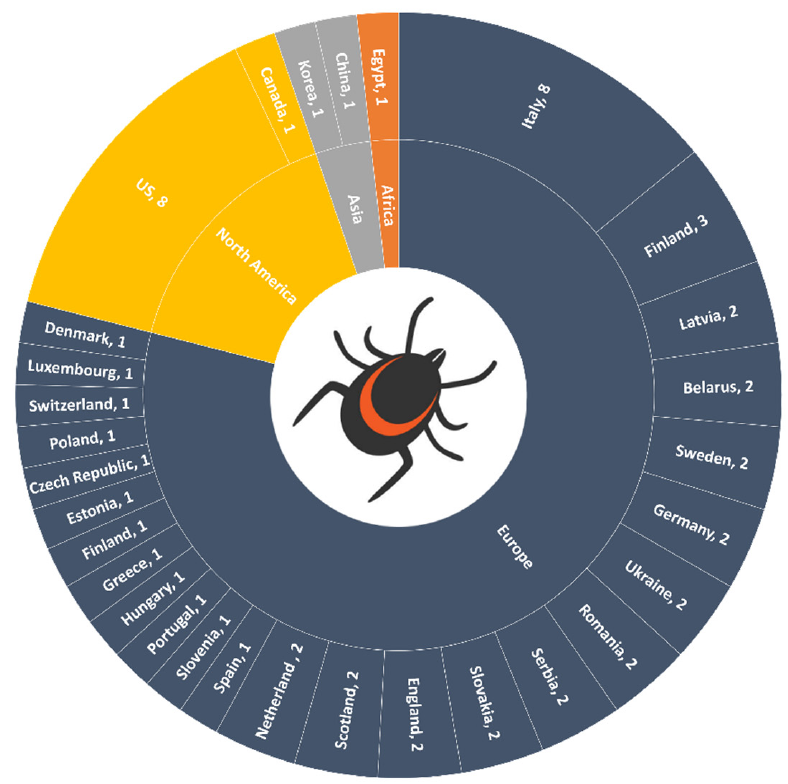
Figure 3. Number of studies reporting Borrelia burgdorferi in different tick species across the world during the last two decades.